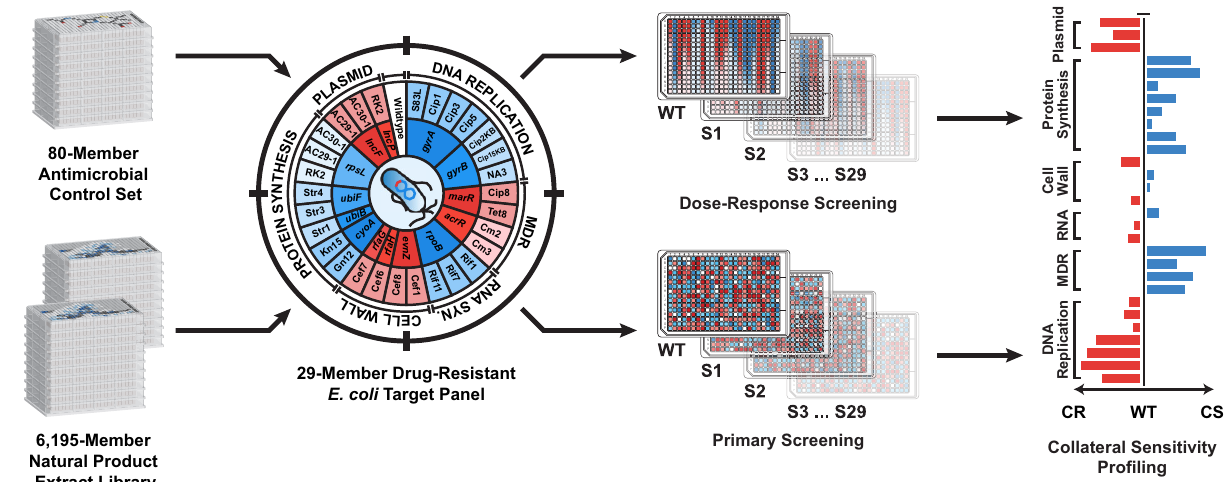
Fig. 1 | Schematic diagram of collateral sensitivity pro fi ling (CSP). Eighty anti- microbials covering a broad range of drug classes (control set for assay optimiza- tion)and anin-house libraryof6195naturalproductextractprefractions served as the primary source of chemical diversity for this study. Both the antimicrobial control set and the natural product library were systematically screened against wildtype E.coli (WT)and 29drug-resistant strains (S1 – S29) as either dilution series (antimicrobials) or at a single stock concentration (natural product prefractions); growth monitored via OD 600 readings. Resulting bioactivity data for each